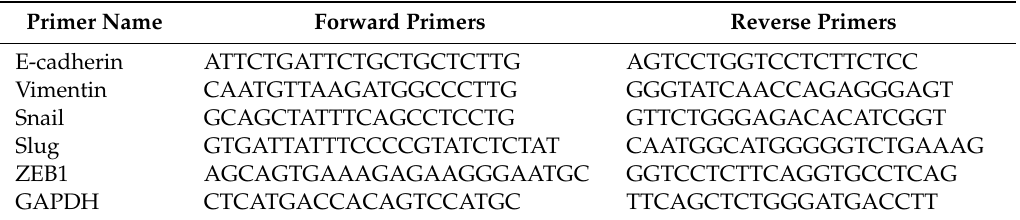
Table 1. List of primer sequences used for Real-Time qRT-PCR in this study.